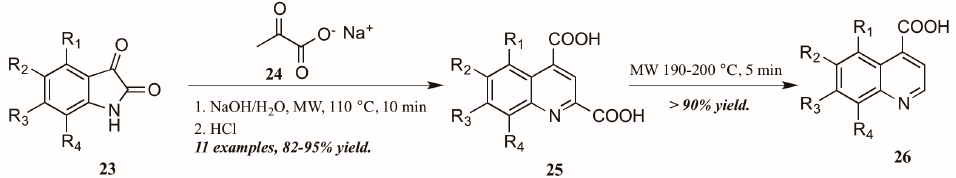
Figure 13. Pfitzinger reaction under microwave irradiation with selective decarboxylation.